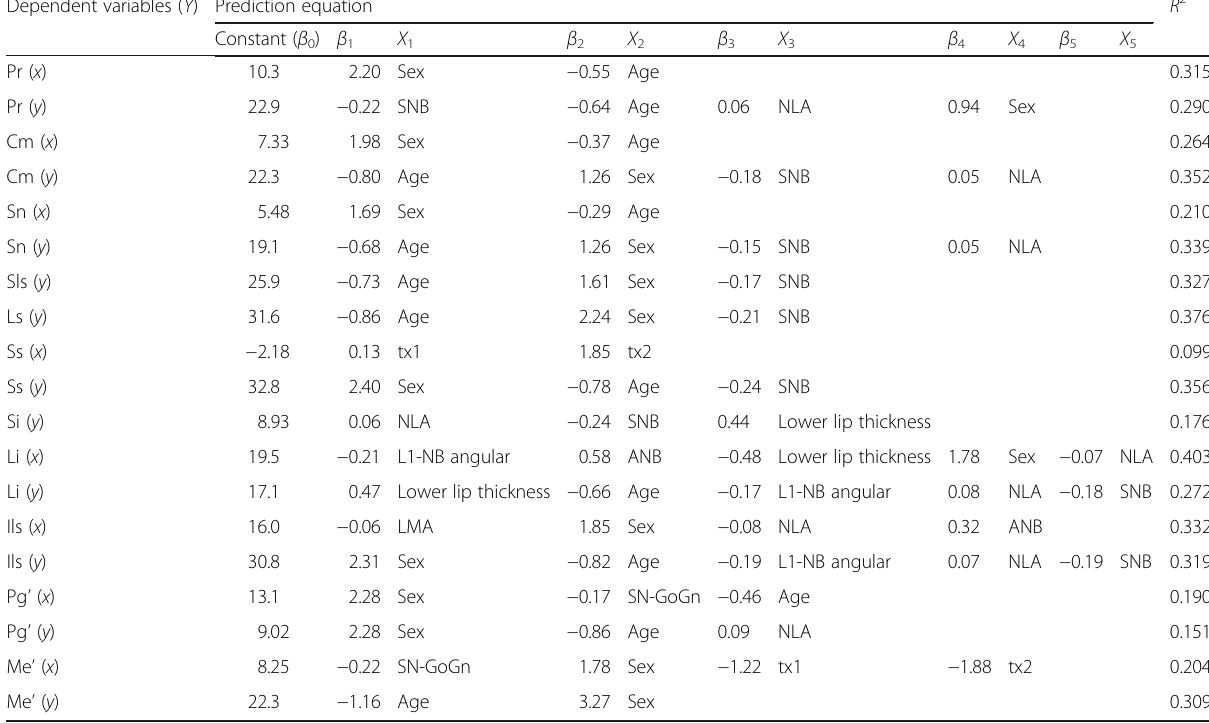
Table 2 Stepwise multiple regression models for soft tissue profile changes Dependent variables ( Y ) Prediction